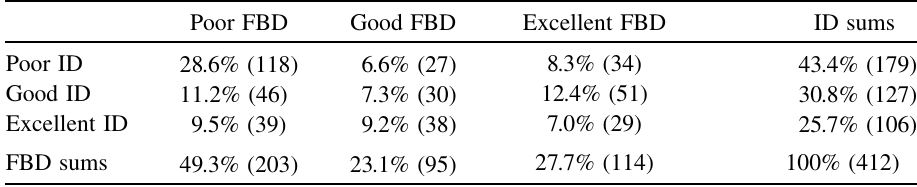
TABLE VI. Crosstab for the ID þ FBD pairs in the light ID group. The number of pairs is reported in